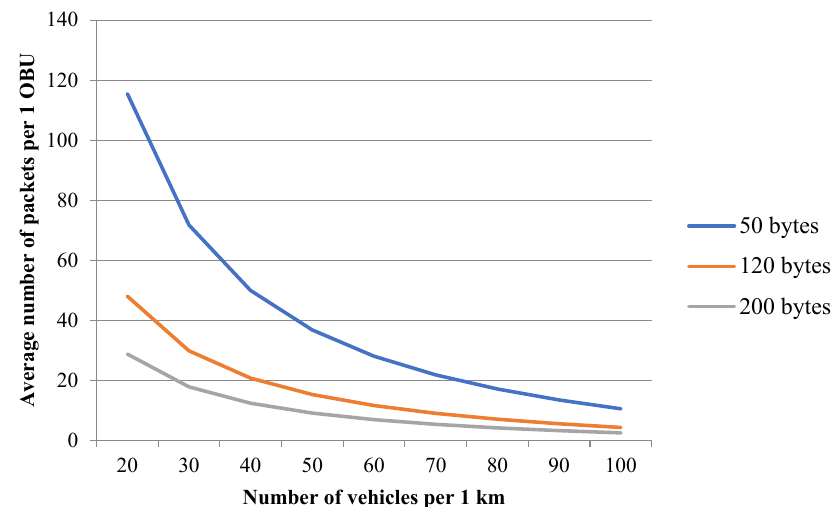
Figure 7. Average number of packets per OBU when using the 3rd confidentiality level.